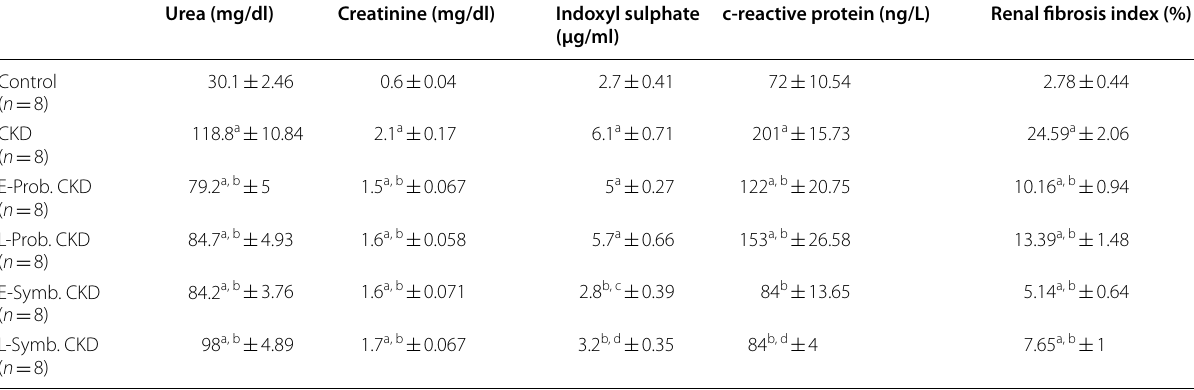
All data are expressed as Mean